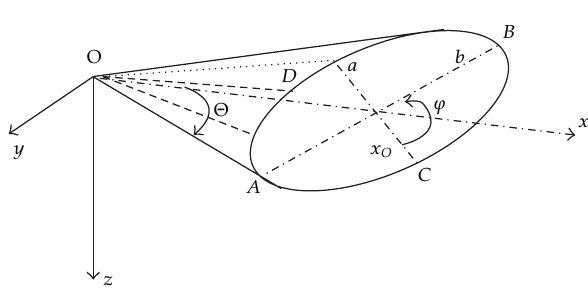
Figure 4: Representation of the spheroconal coordinates in the elliptic